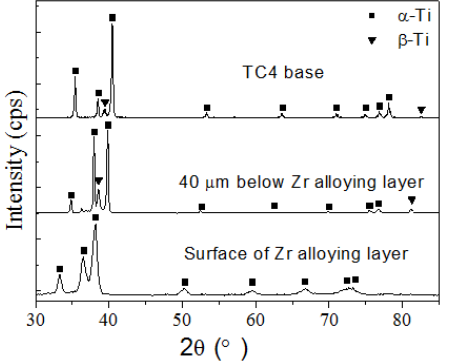
Figure 9. XRD results of plasma Zr alloying specimen.